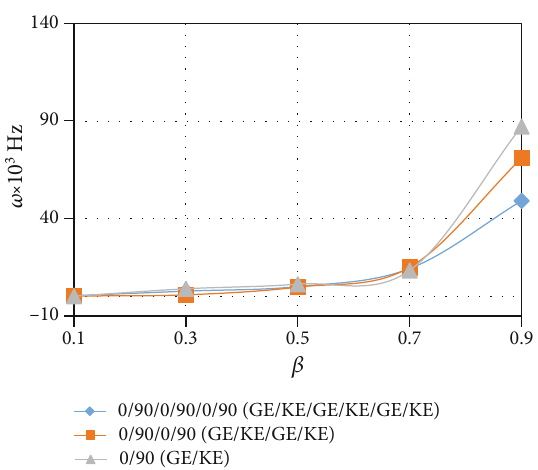
Figure 4: Variation of angular frequency and radius ratio of 4- layered annular circular plates. S-S.